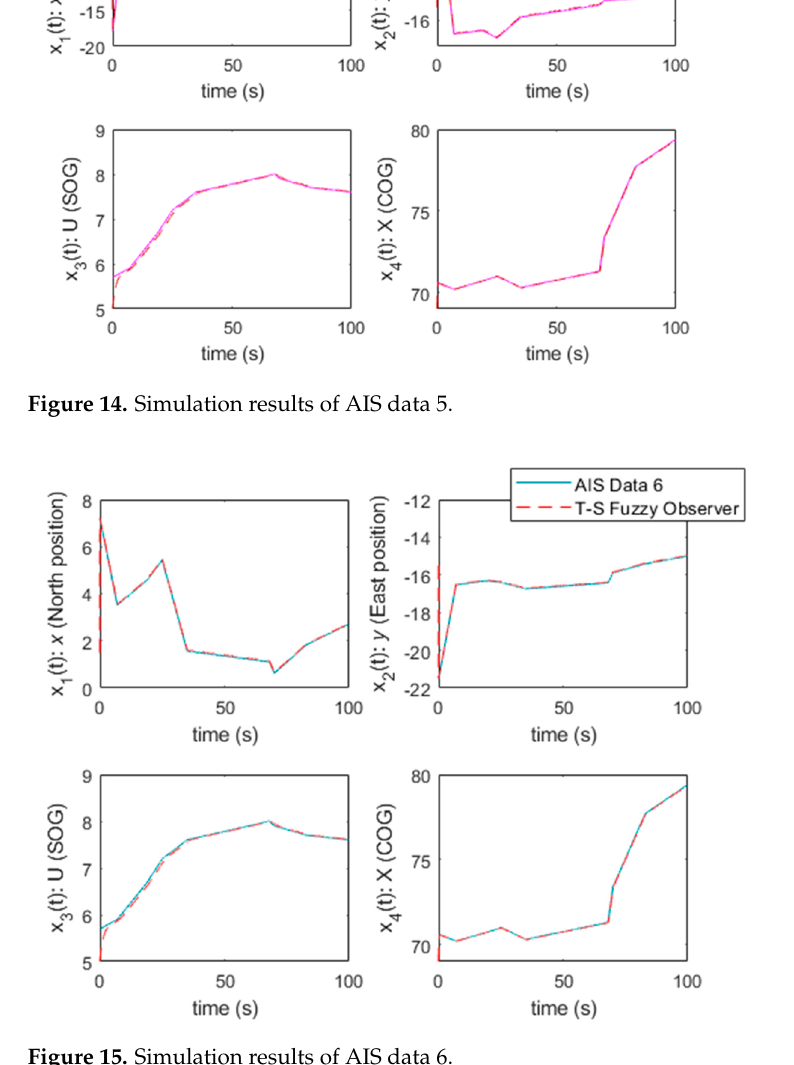
Figure 15. Simulation results of AIS data 6.